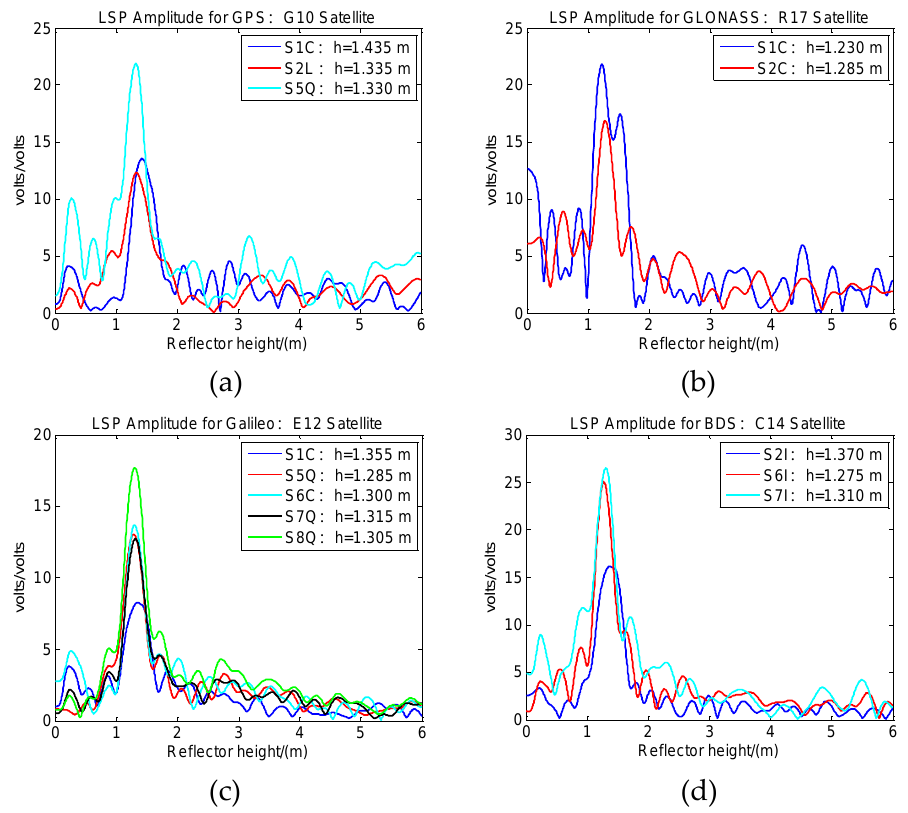
Figure 9. Multi-GNSS and multi-frequency LSP analysis results: ( a ) GPS LSP results; ( b ) GLONASS LSP results; ( c ) Galileo LSP results; ( d ) BDS LSP results.